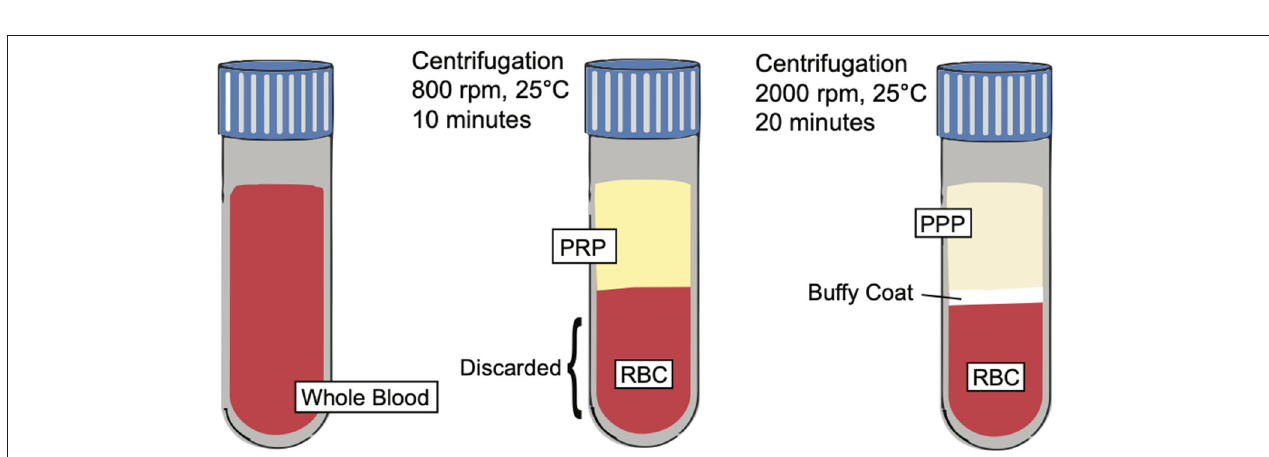
FIGURE 3 | PRP preparation. Illustration depicting the preparation of PRP and showing the separation of key blood components such as platelet poor plasma (PPP), buffy coat, and red blood cells (RBCs) based on centrifugation techniques. progression from the telogen to the anagen phase, leading to active hair growth (19). Wnt/ β -catenin signaling is therefore indispensable for the formation of hair follicles as well as the promotion of hair